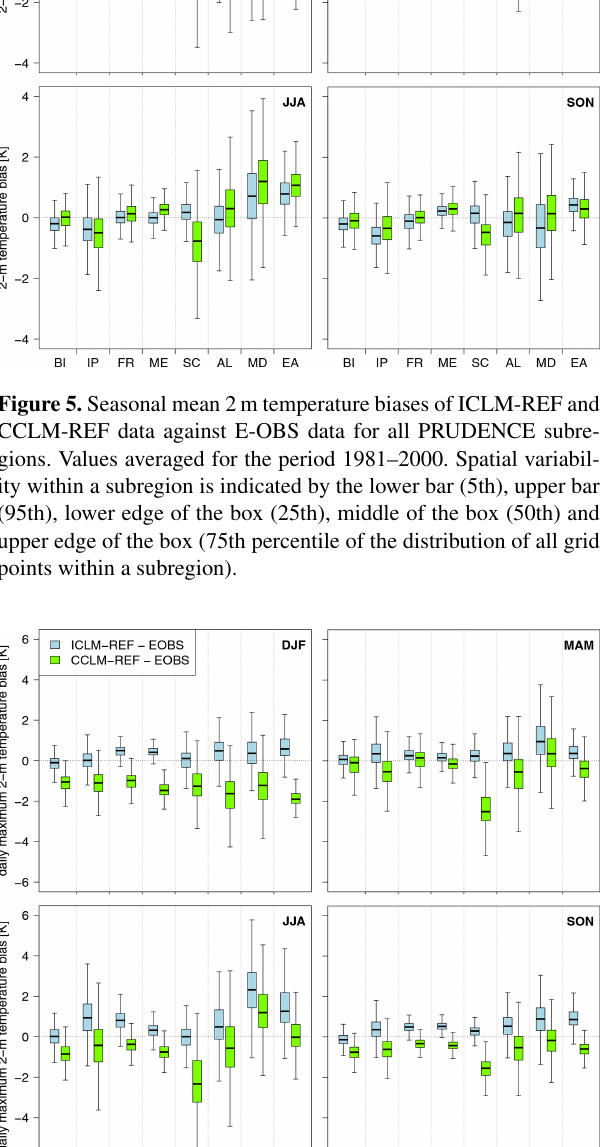
the range in CCLM-REF was − 2.5 to 1.2 K. In summer, the bias was larger for both models. CCLM-REF had larger spa- tial differences among the subregions than ICLM-REF. Sim- ilarly, the bias of the minimum 2 m temperature of ICLM- REF was reduced compared to CCLM-REF ( − 1.2 to 0.5 K